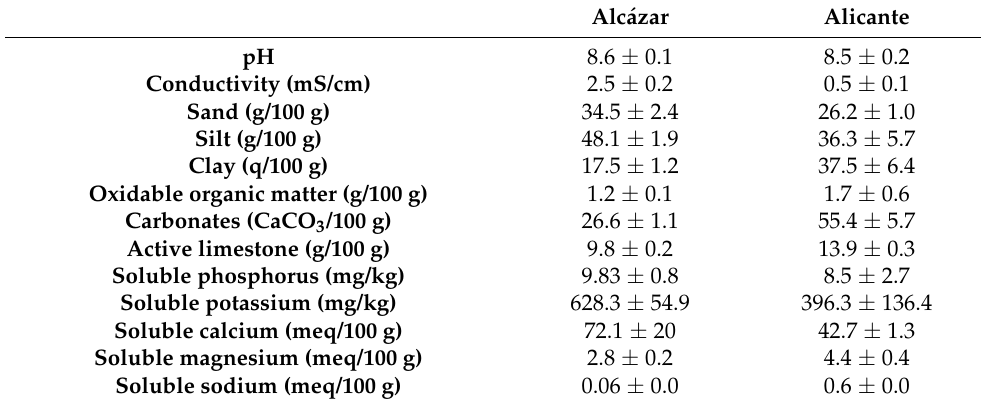
Figure A1. Location of experimental plantations in Spain: inland Alcázar de San Juan site (semi-arid Mediterranean with cold winters (Bsk)) and coastal Alicante site (arid Mediterranean sub-desertic with warm summers and winters (Bsh)). Table A1. Mean ± standard deviation of soil index from Alc á zar and Alicante sites. Three composite soil samples were collected from establishment